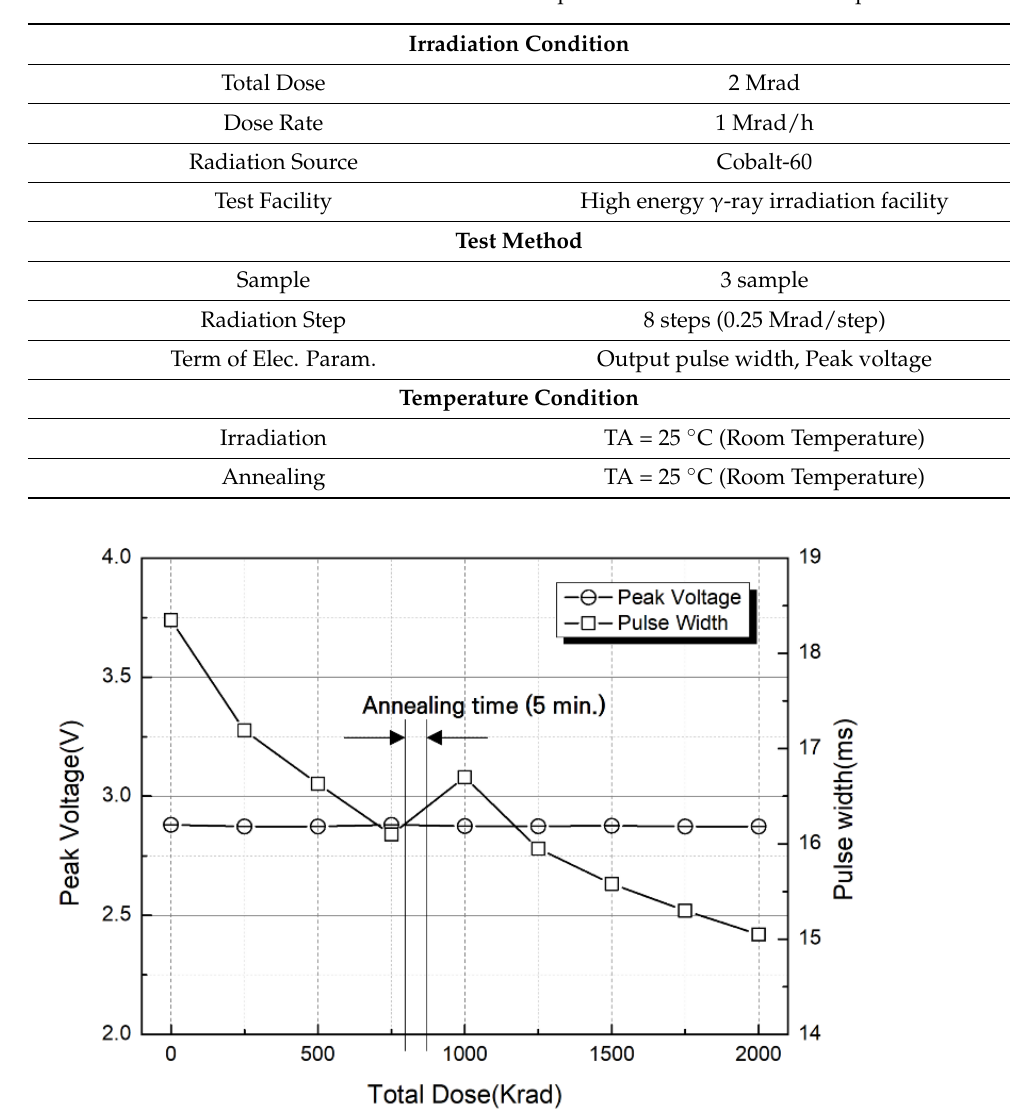
Table 2. TID effect test conditions and test method of pulsed-radiation detection chip.